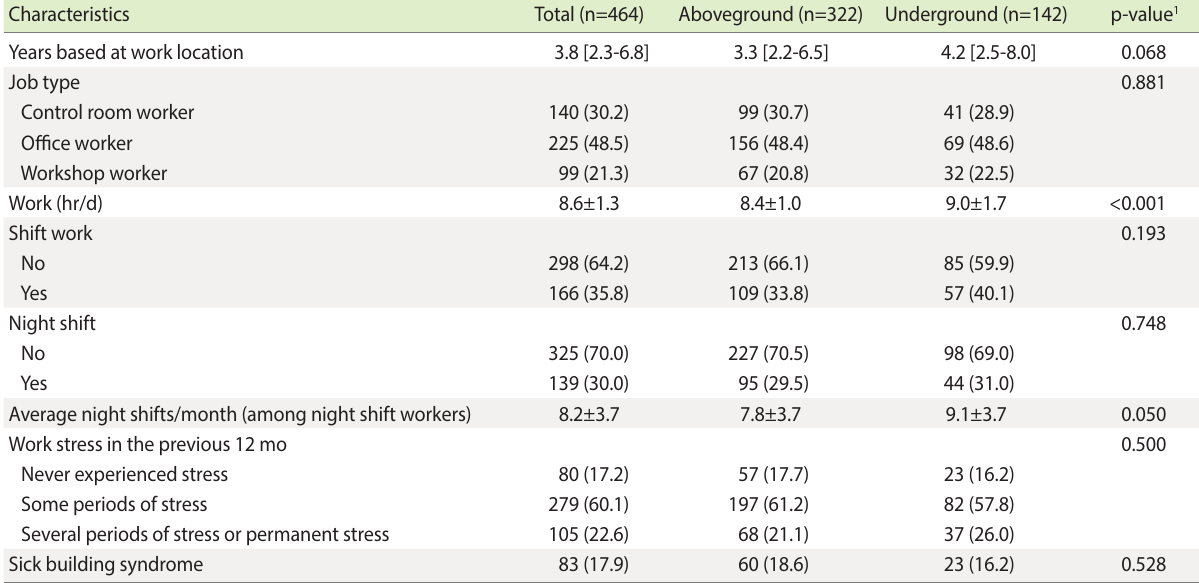
Table 5. Work-related characteristics of the study cohort at baseline